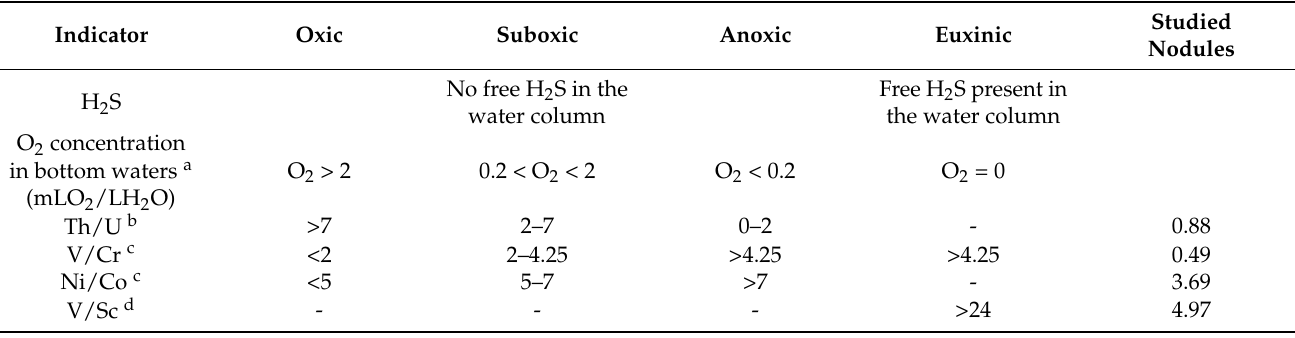
Table 4. Redox classification of the depositional environment.